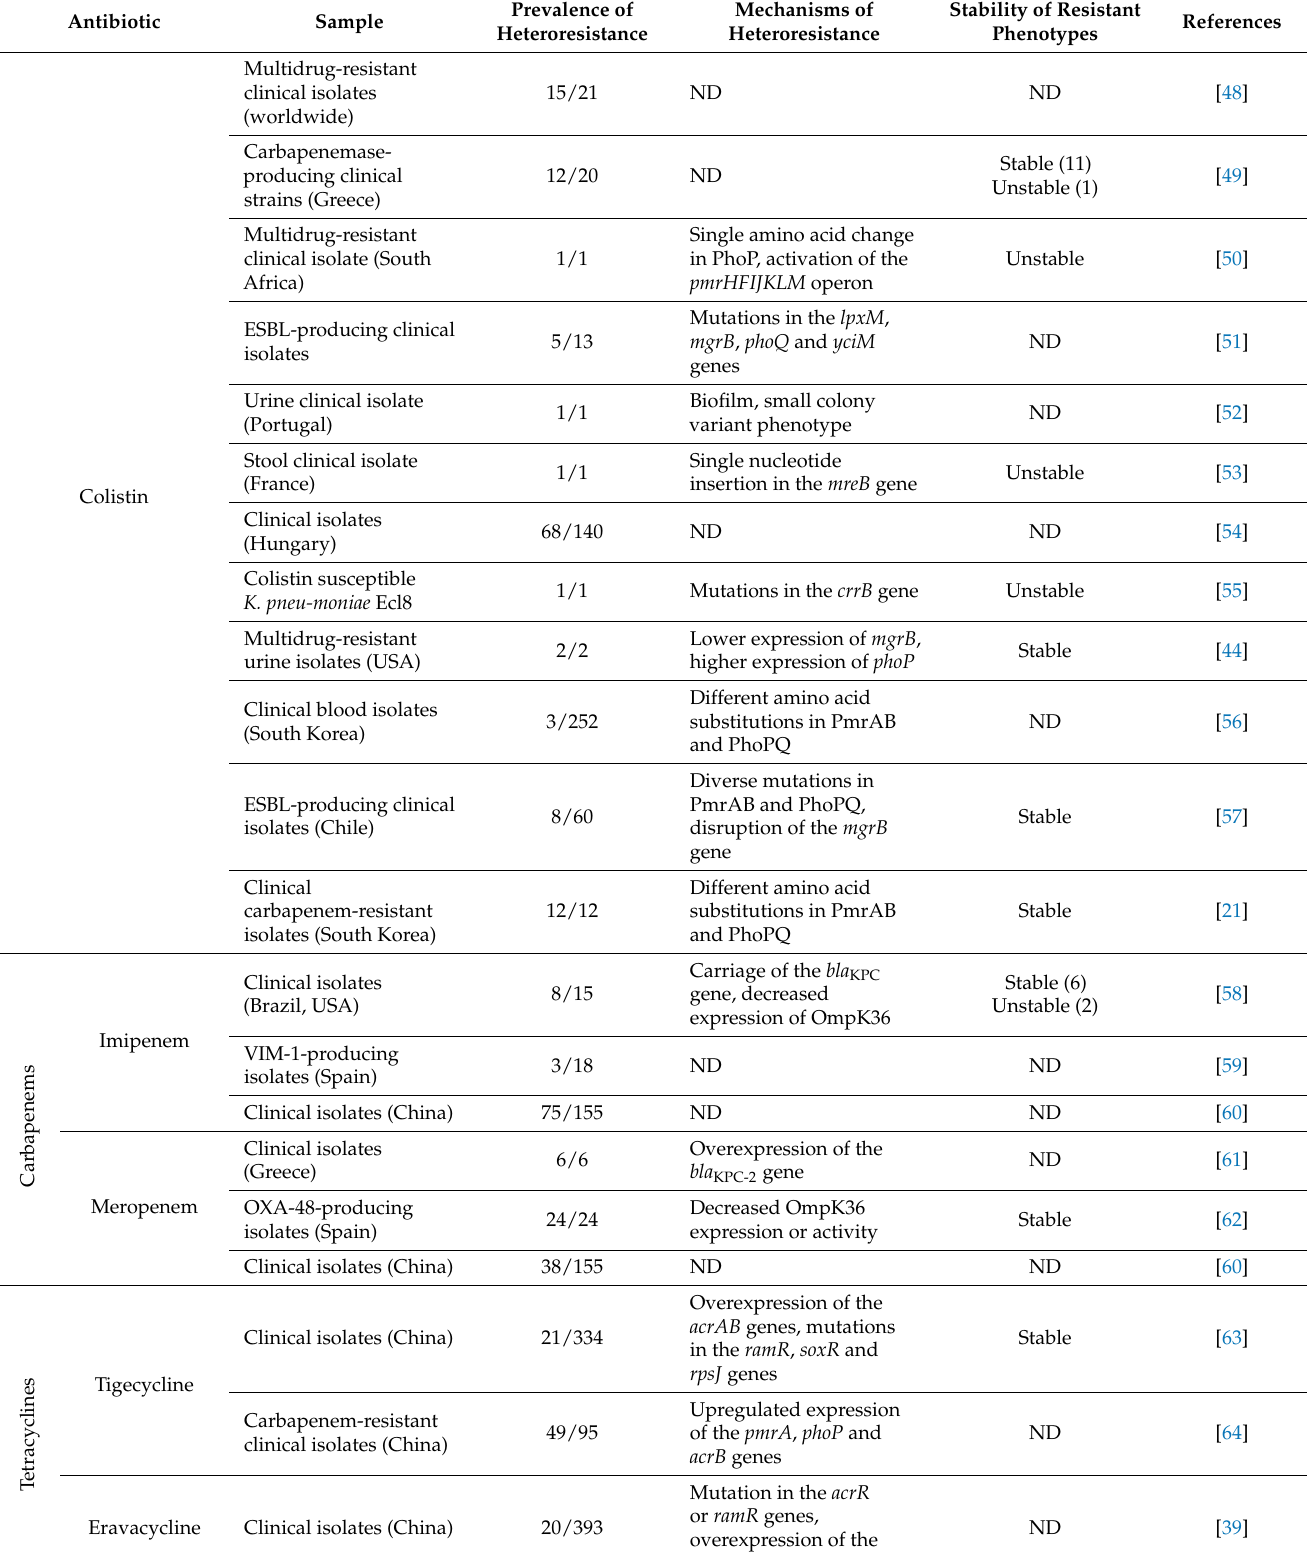
Table 1. Examples of heteroresistance in K. pneumoniae